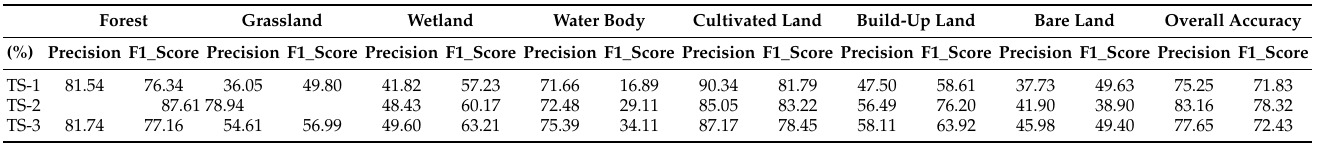
Table 3. Classification accuracy for the Jing-Jin-Ji region of PSPNet on the four training sets where forest and grassland are merged as on class in TS-2. Forest Grassland Wetland Water Body Cultivated Land Build-Up Land Bare Land Overall